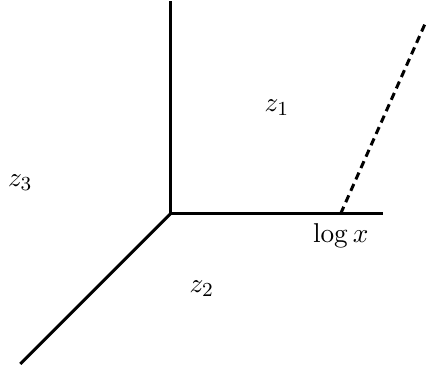
Figure 5. A toric brane in the neighborhood of a vertex, anywhere in the toric